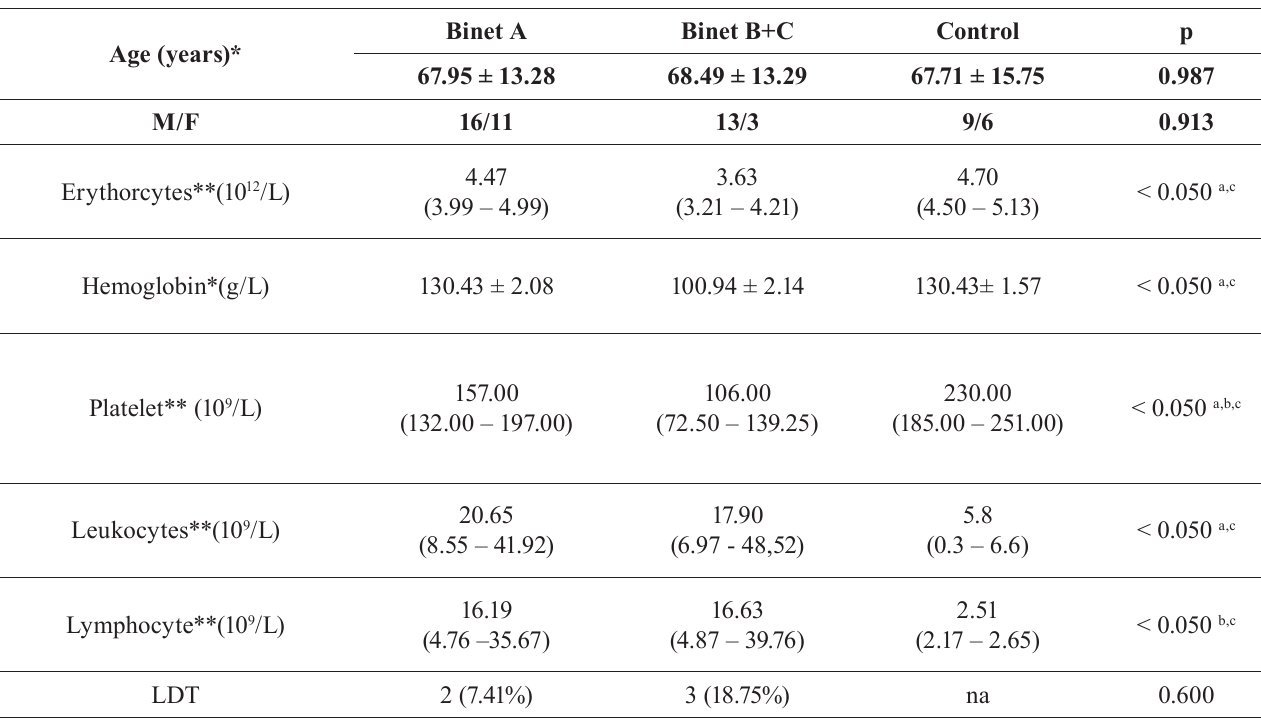
Table I - C linical and Laboratory (blood analysis) of patients with CLL and control